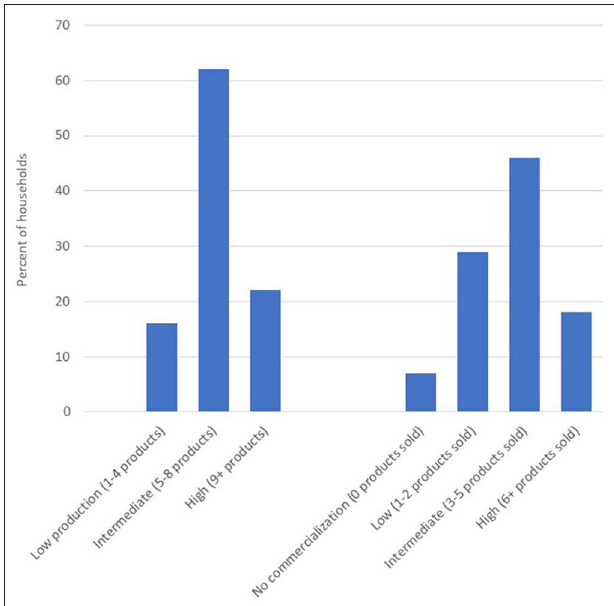
FIGURE 2 | Production diversification (numbers of agricultural products cultivated) and commercialization diversification (numbers of agricultural products sold) of farming households in Hoima ( n = 140). Source: Mubiru and Kristjanson (2012)